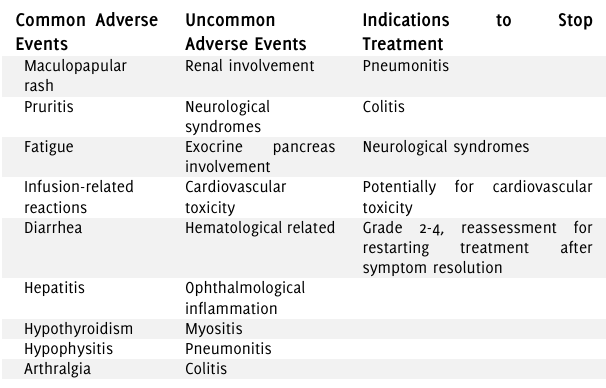
Legend: The table was adapted from the Society for Immunotherapy of Cancer (SITC) Toxicity Management Working Group, reference 31: Puzanov I, Diab A, Abdallah K, Bingham CO, Brogdon C, Dadu R, et al. Managing toxicities associated with immune checkpoint inhibitors: Consensus recommendations from the Society for Immunotherapy of Cancer (SITC) Toxicity Management Working Group. J Immunother Cancer. 2017;5(1):1–28. 0.36-0.64, P<0.001) and overall survival (HR 0.78, 95% CI, 0.50-1.20). 37 Median follow-up in this study was 527 days. In the EGFR-